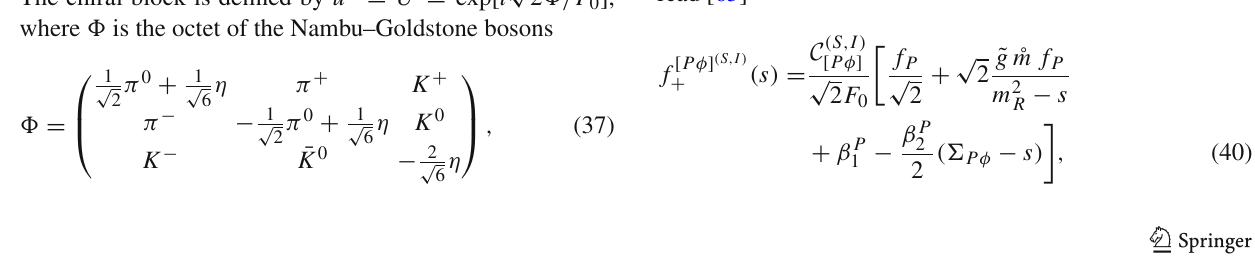
(cid:21) (cid:22) ( m − M π ) 2 = I B